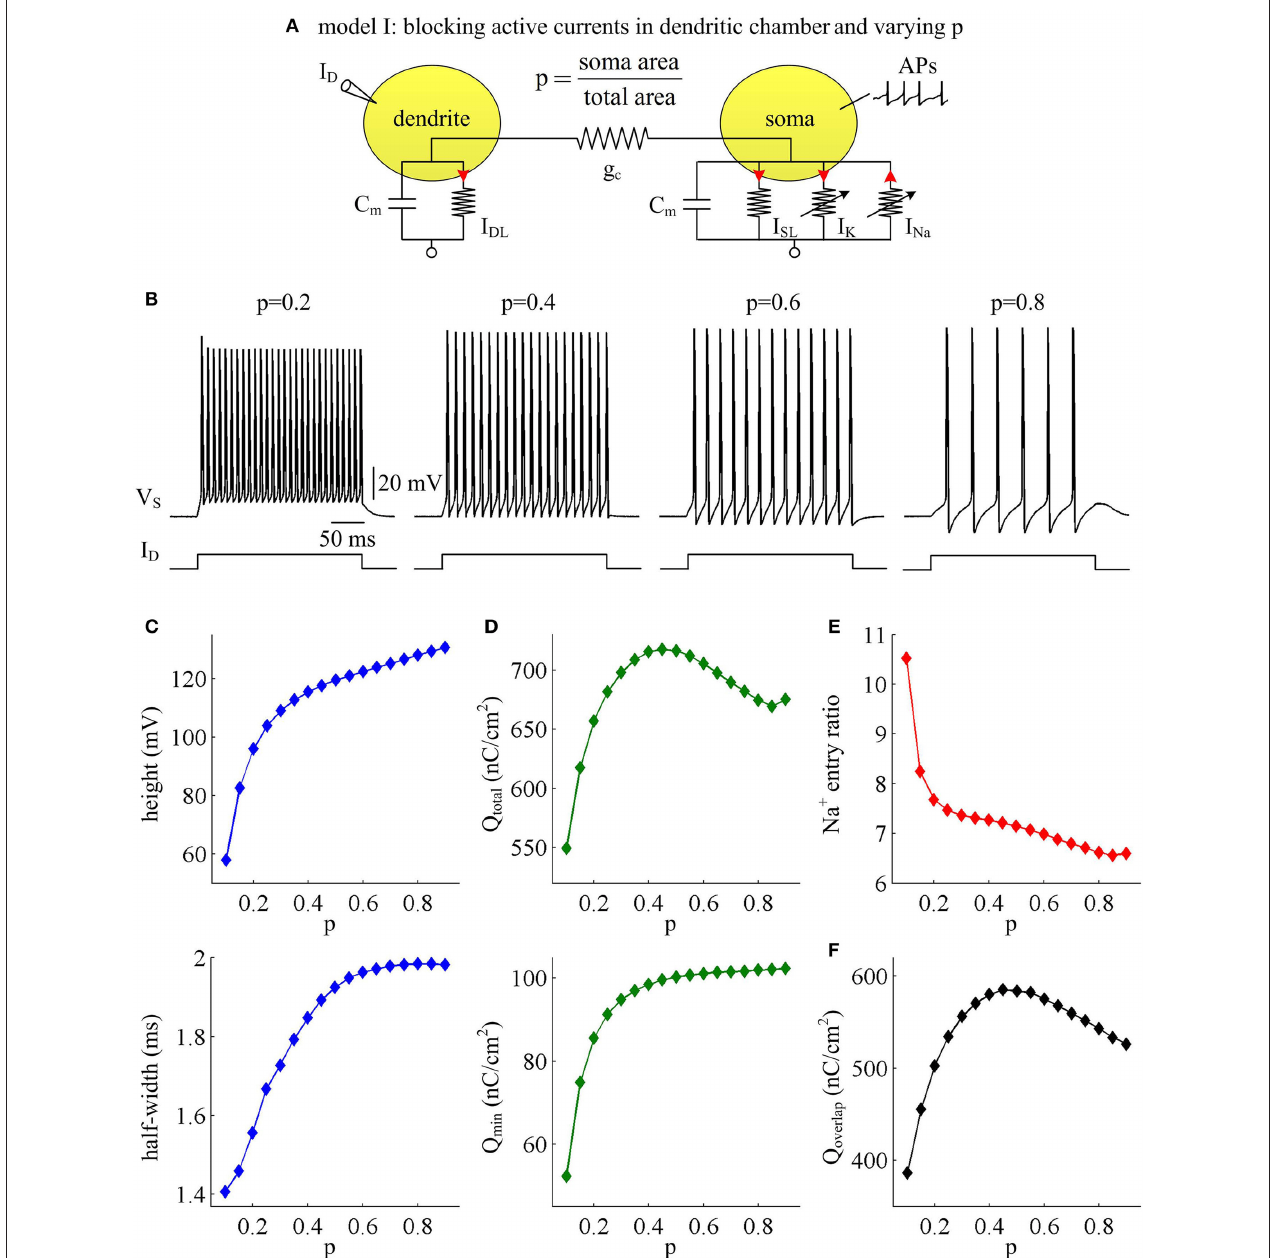
FIGURE 1 | AP shape and metabolic efficiency vary with dendrite area in model I. (A) Schematic of model I. There are no active channels in its dendritic chamber. Red arrows indicate the direction of ionic current. We set coupling conductance to g c = 0.5 mS / cm 2 and vary morphological parameter p . (B) Responses of membrane voltage V S recorded from the soma with different values of p , which are indicated on the top of each panel. (C) Both height and half-width of the AP increase as a function of p . (D) Top panel: total Na + load Q total during an AP is plotted as a function of p . Note that Q total reaches a maximum with moderate value of p . Bottom panel: minimal Na + load Q min increases as a function of p . (E) Na + entry ratio decreases as a function of p . (F) Overlap Na + load Q overlap during an AP is plotted as a function of p . Similar to Q total , Q overlap also reaches a maximum with moderate value of p . Dendritic input is I D = 3 µ A / cm 2